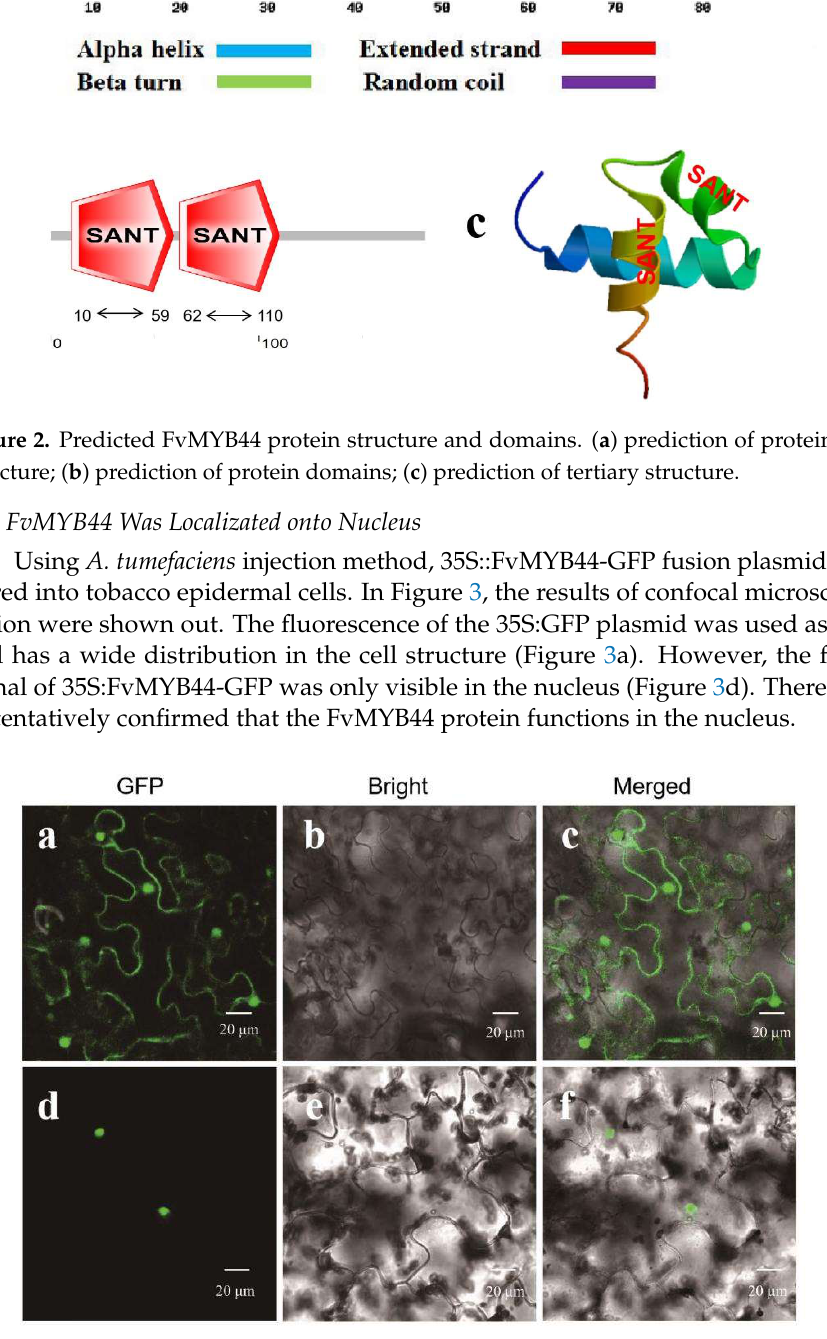
Figure 3. Subcellular localization of FvMYB44 in tobacco leaf epidermal cells. The 35S:GFP and 35S:FvMYB44 plasmids were injected into the cells by Agrobacterium tumefaciens injection method. ( a , d ) GFP fluorescence, ( b , e ) Bright-field, ( c , f ) Merged. Bar = 50 µm.